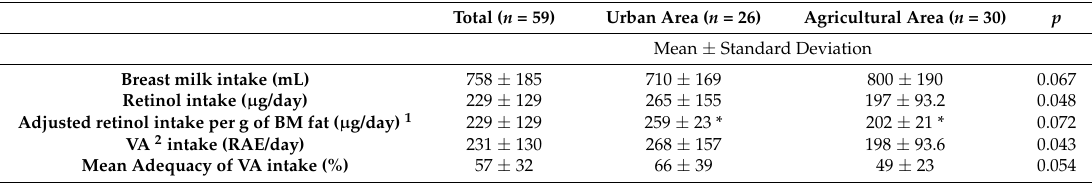
Table 4. Breast milk intake and adequacy of intake of vitamin A (VA) in participating